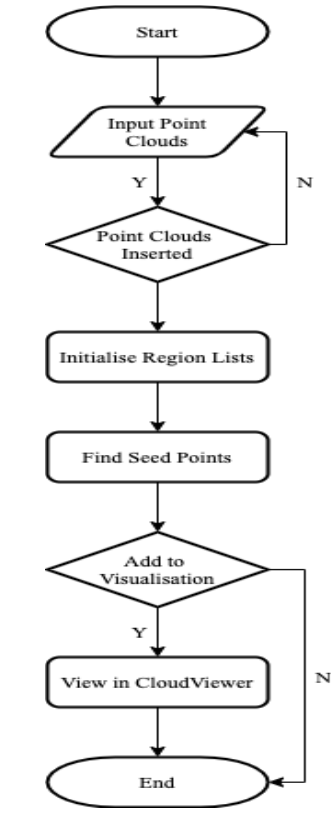
Figure 8: Flowchart of Region-Growing